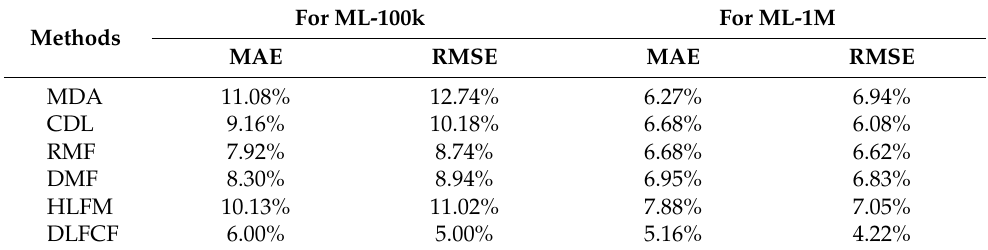
Table 4. Performance improvement results in DELCR for both datasets.